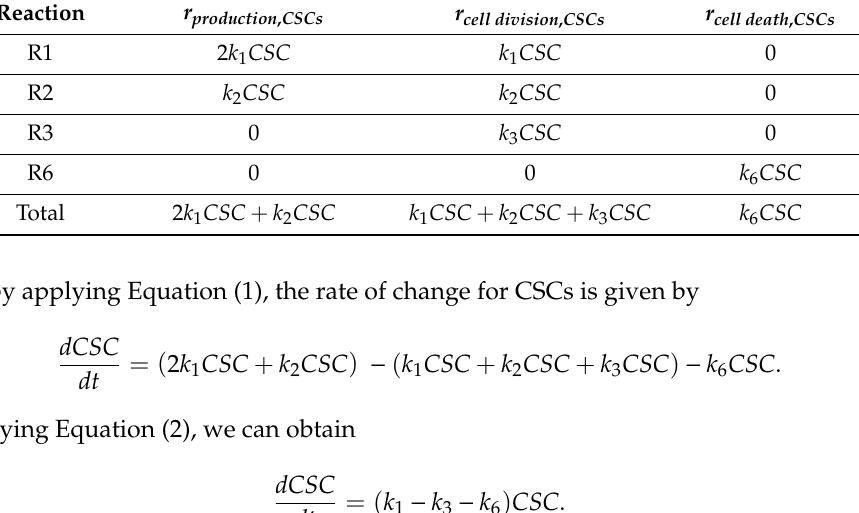
Table 1. Summary of the rates of consumption and production of CSCs.